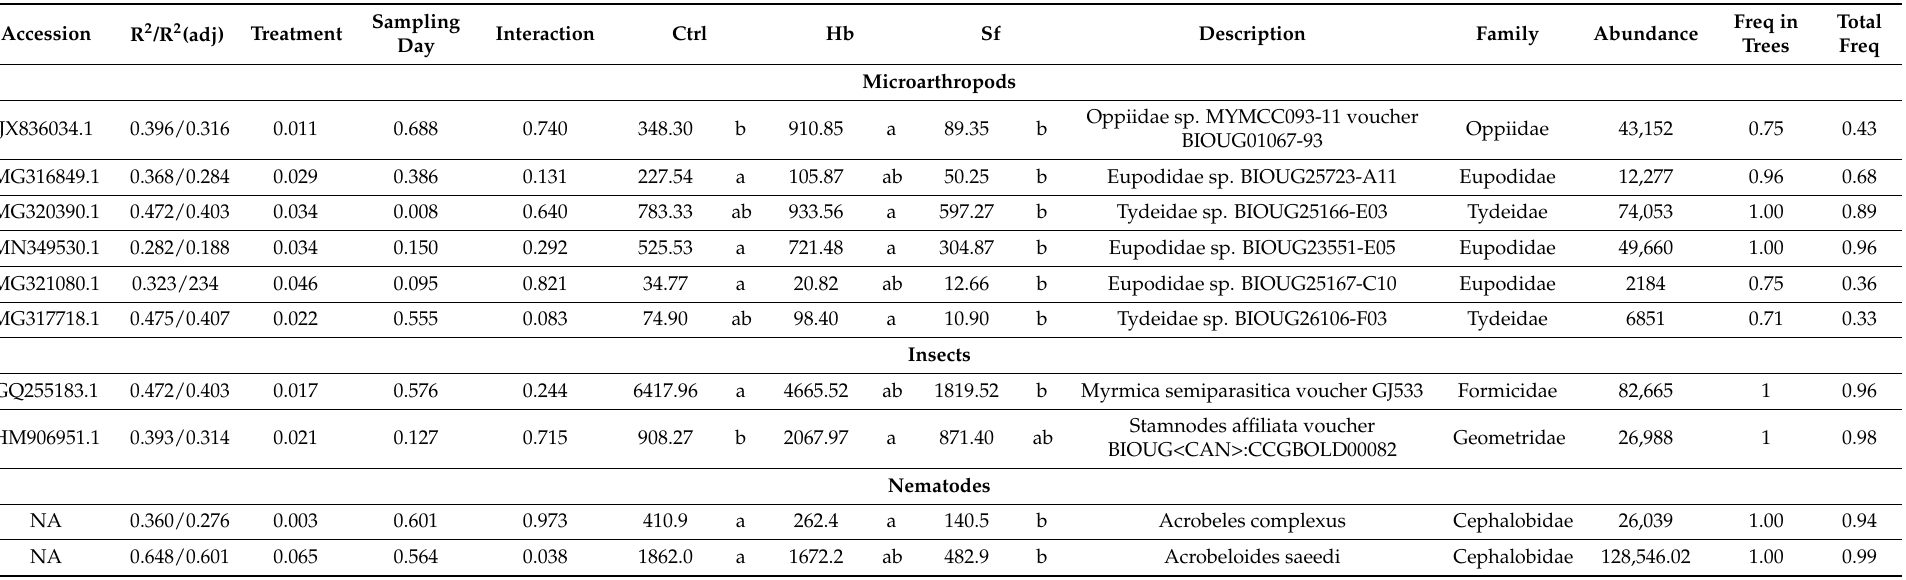
Table 3. Significant responses of MOTUs in the four major groups (microarthropods, insects and nematodes) according to two-way repeated measures ANOVA. R squared values show proportion of variance that can be explained by the independent variable. Means comparison performed using Least Significant Difference (LSD-test) with p -values adjusted by the Bonferroni correction approach. Treatments with the same letter following mean read abundance of the untreated control (Ctrl), Heterorhabditis bacteriophora (Hb) and Steinernema feltiae (Sf) do not differ ( p < 0.05). Abundance indicates the total read abundance of the family. Analysis was applied only to taxa occurring in more than 75% of the 24 treated plots (Plot freq), while “Total freq” indicates the frequency of occurrence in the 96